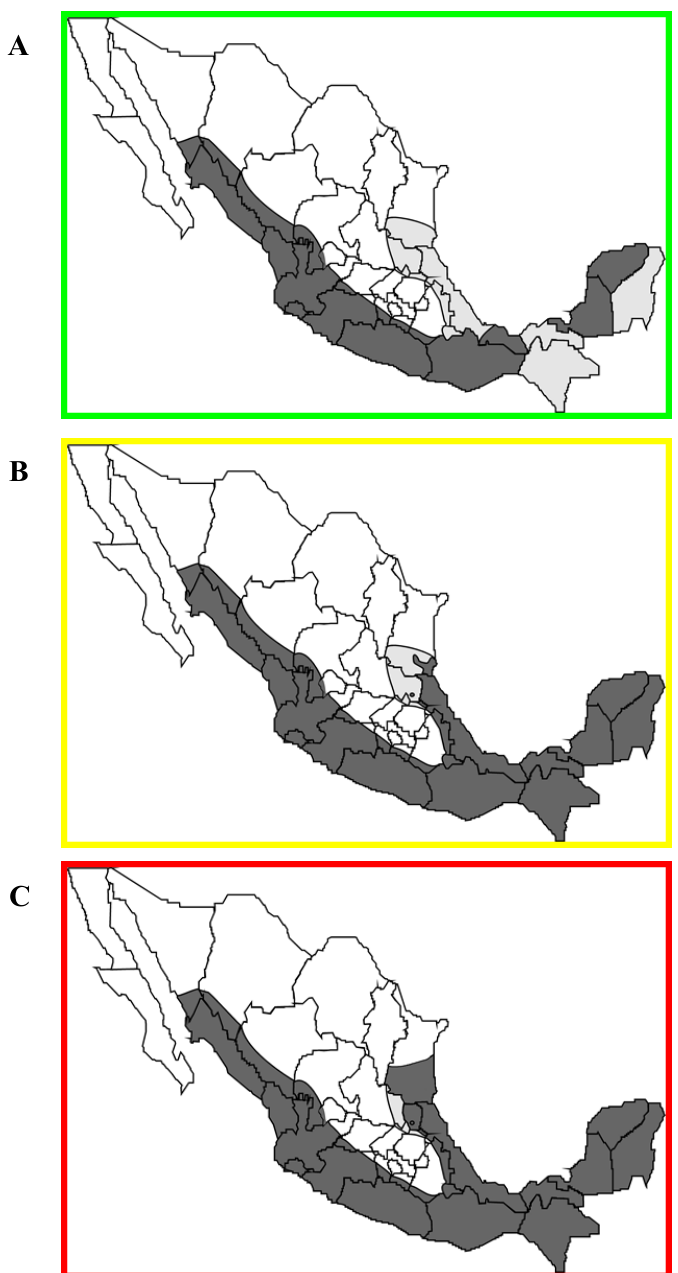
Figure 4. Distribution of rabies-affected areas of Mexico over three decades; ( A ) 1970s; ( B ) 1990s; ( C ) 2000s. Black indicates areas with populations of rabies-affected populations of vampire bats, grey indicates areas with populations of vampire bats but rabies